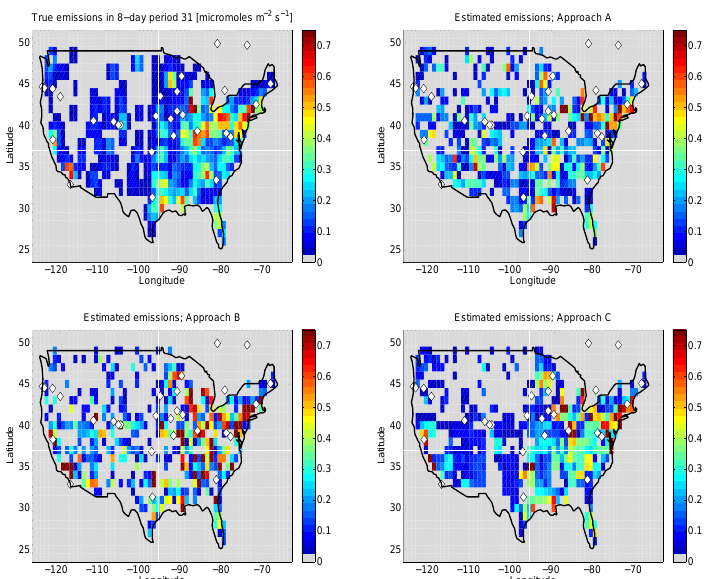
Figure 2. Plots of ffCO 2 emissions during the 31st 8-day period. The units are micromoles of C m − 2 s − 1 . Emissions below 0.02 micromoles of C m − 2 s − 1 are grayed out. Top left, we plot true emissions from the Vulcan inventory. Top right, the estimates from approach A. Bottom left and right figures contain the estimates obtained from approaches B and C, respectively. Each figure contains the measurement towers as white diamonds. Each figure is also divided into quadrants. We see that approach A, unconstrained by f pr provides low levels of (erroneous) emissions in large swathes of the western quadrants. Approach B reflects f pr very strongly. Approach C provides a balance between the influence of f pr and the information in y obs .